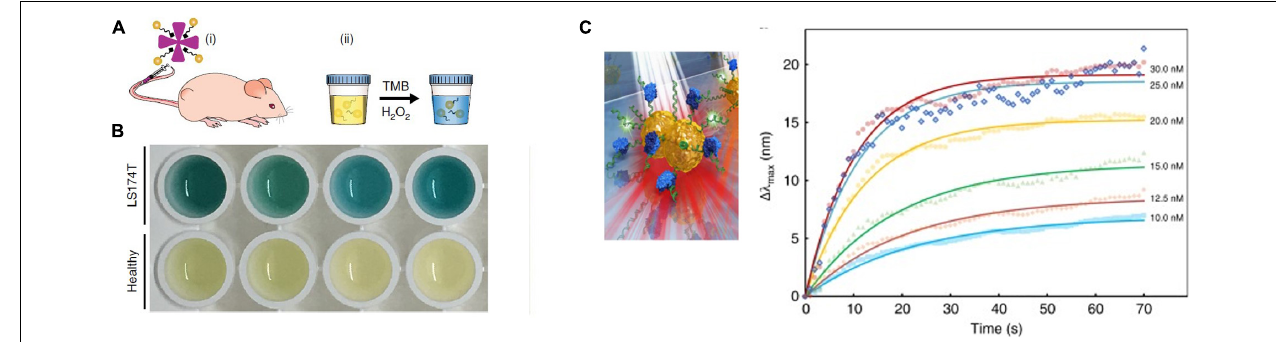
FIGURE 8 | (A) Schematic of the renal clearance assay, including two steps (i and ii). (B) Colorimetric assay of urine from tumor and healthy-bearing mice injected with AuNC-P220-Nav. The blue color urine is belonging to samples from tumor-bearing mice. Reprinted with permission from Loynachan et al. (2019), Copyright (2019), Springer Nature. (C) Illustrations of single NP sensing (sNPS) models and real-time monitoring of MutS binding to each point mutation and a homoduplex DNA, non-specific sequence binding of MutS to point mutations change LSPR signals. Error bars represent mean ± SEM. Reprinted with permission from Ma et al. (2019).